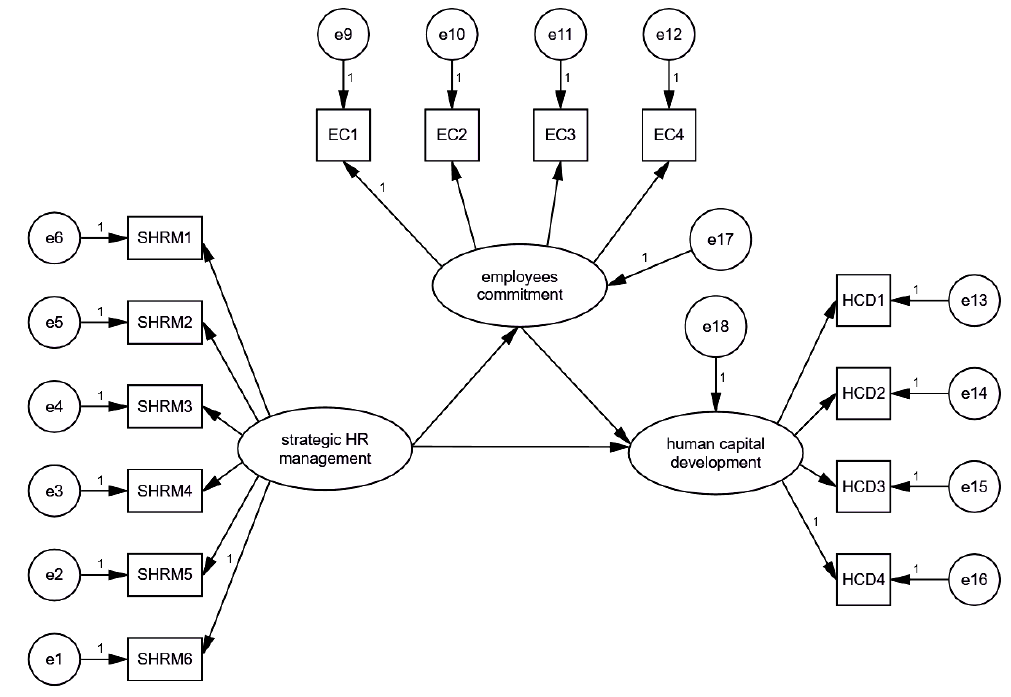
Figure 3. Structural model in